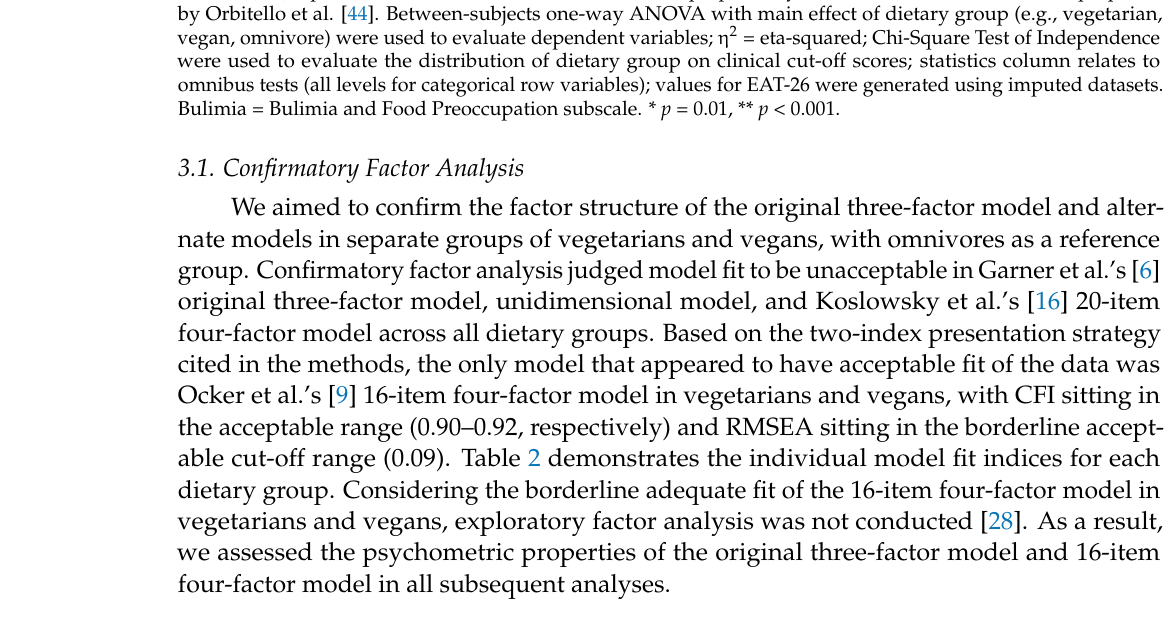
Table 2. Confirmatory factor analysis fit indices of the original and alternative models of the Eating Attitudes Test (EAT) in vegetarians, vegans, and